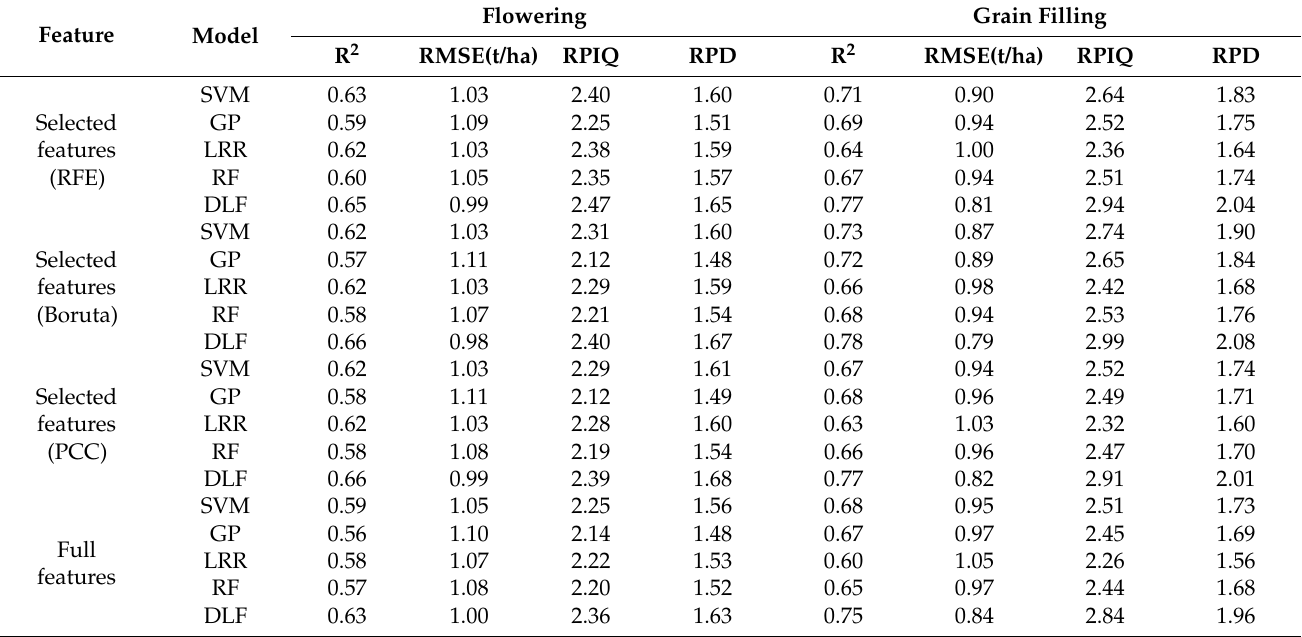
Table 4. Test accuracies of the support vector machine (SVM), Gaussian process (GP), linear ridge regression (LRR), random forest (RF), and decision layer fusion (DLF) models in predicting winter wheat yield.